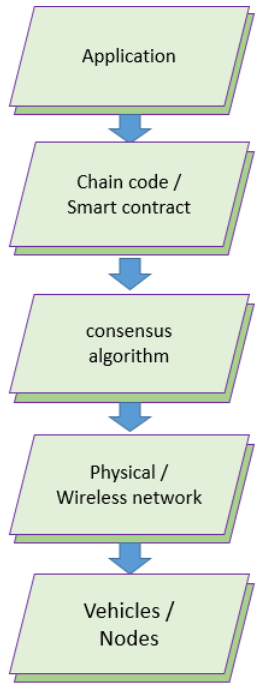
Figure 1. Layers of the proposed network.